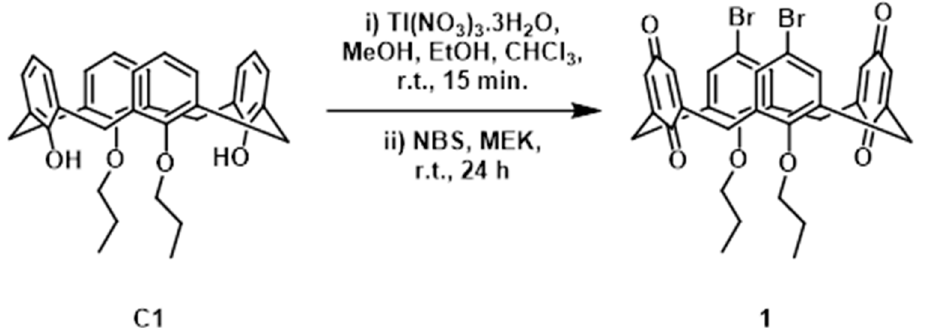
Scheme 1. Synthesis of 1 using a method developed by Genorio [2].